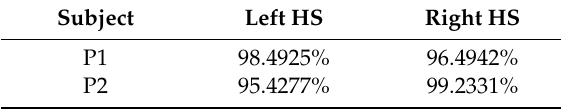
Table 3. Success rates of the gait detection algorithms.